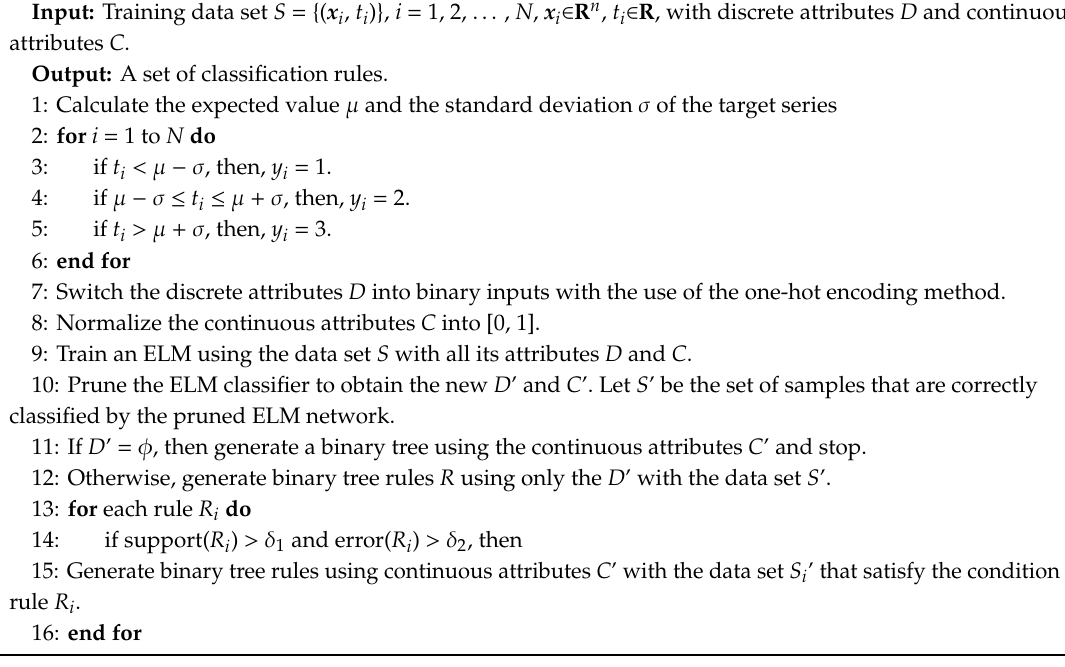
Algorithm 1: Rule extraction from ELM